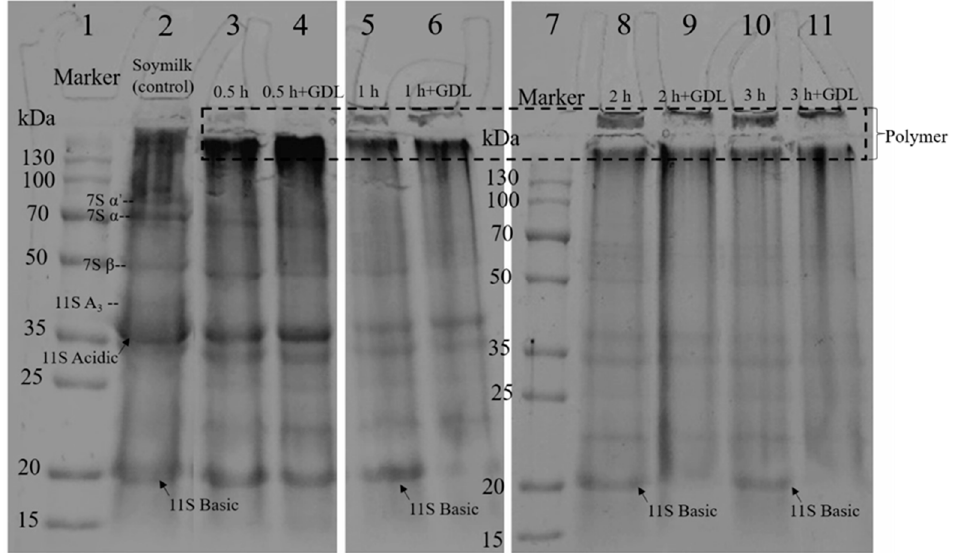
Figure 1. SDS-PAGE profiles of soymilk samples pre-incubated with TGase for various periods of 0.5, 1, 2 and 3 h, respectively, (corresponding to lanes 3, 5, 8 and 10, respectively) and then coagulated by GDL (corresponding to lanes 4, 6, 9 and 11, respectively).